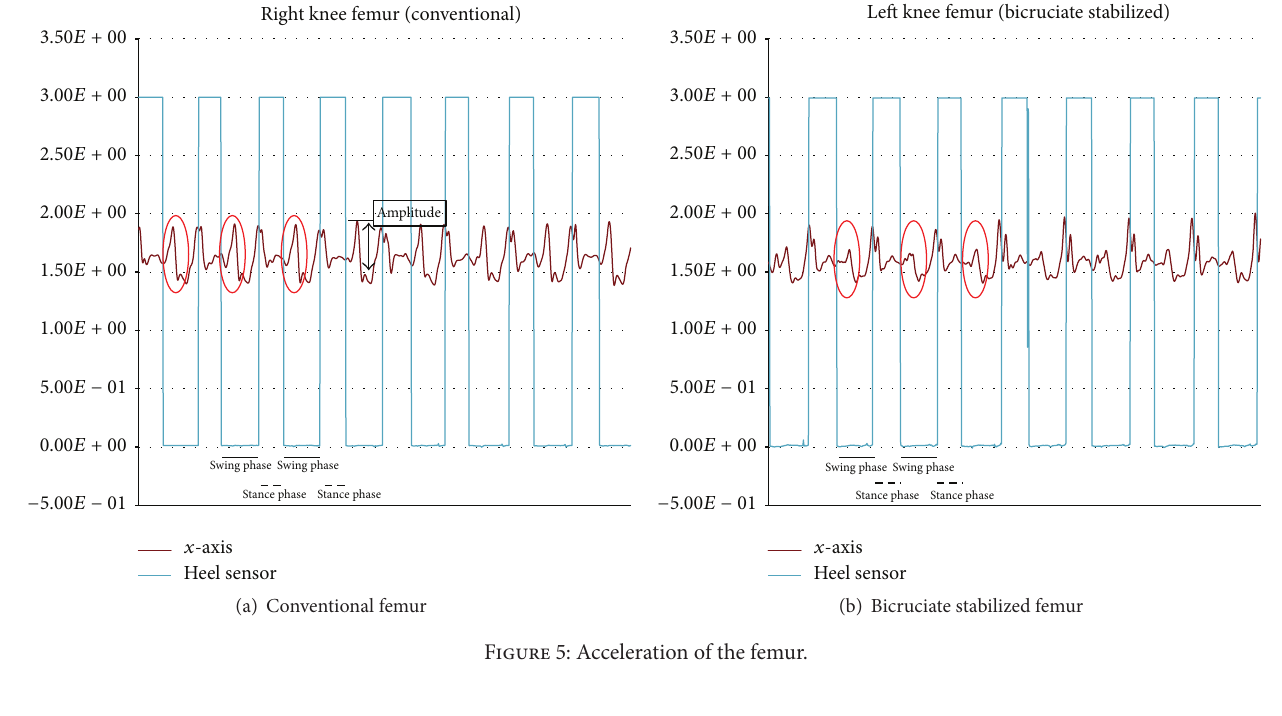
Figure 5: Acceleration of the femur.